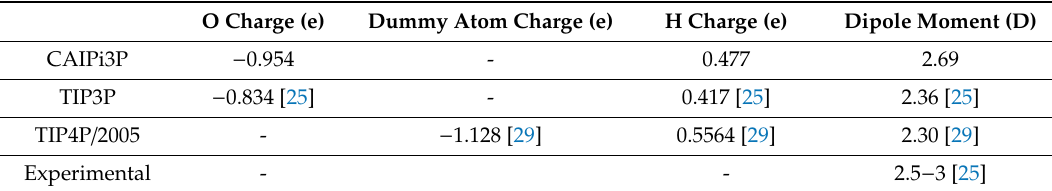
Table 1. Partial atomic charges and resulting dipole moments for CAIPi3P, TIP3P, and TIP4P / 2005 water models. O Charge (e) Dummy Atom Charge (e) H Charge (e) Dipole Moment